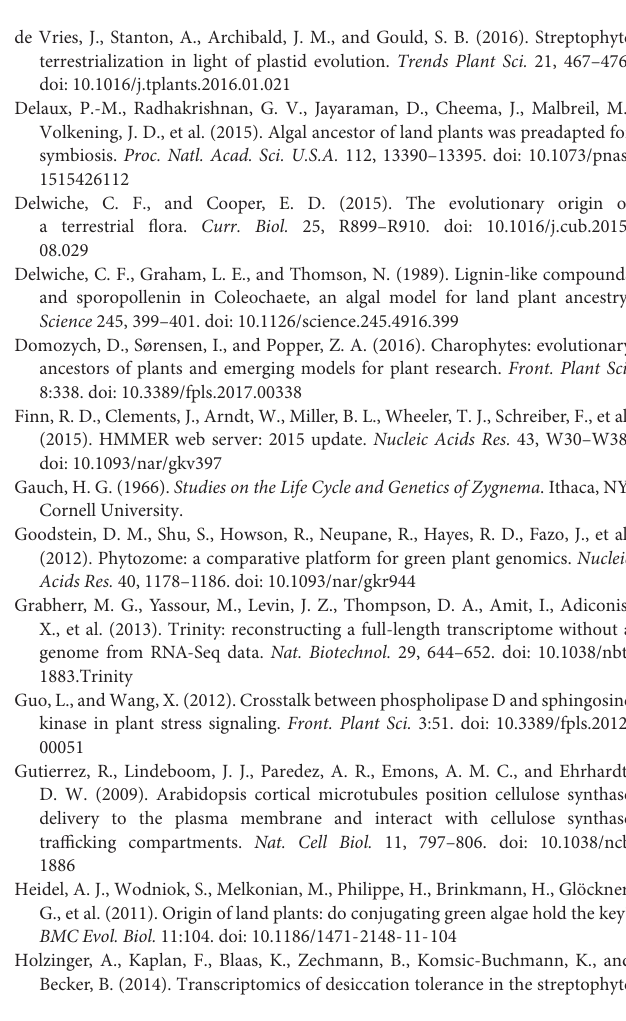
FIGURE S1 | The phylogeny of GT8 proteins from selected species of land plants and algae. In total 262 GT43 protein sequences of 14 plant and algal species were used to build this phylogeny (see section “Materials and Methods”). For Arabidopsis and rice proteins, the gene names (adopted from Yin et al., 2010) were included in the tree leaves. Arabidopsis proteins that are known to be xylan biosynthesis-related were indicated in red (AtIRX8, AtGUX1-5, and AtPARVUS). The UTEX 1559 proteins that were selected for qRT-PCR analysis were highlighted with orange background and the proposed gene names ( Table 5 ) were indicated with black lines. FIGURE S2 | The phylogeny of GT43 proteins from selected species of land plants and algae. In total 52 GT43 protein sequences of 14 plant and algal species were used to build this phylogeny (see section “Materials and Methods”). For Arabidopsis proteins, the gene names (adopted from Taujale and Yin, 2015) were